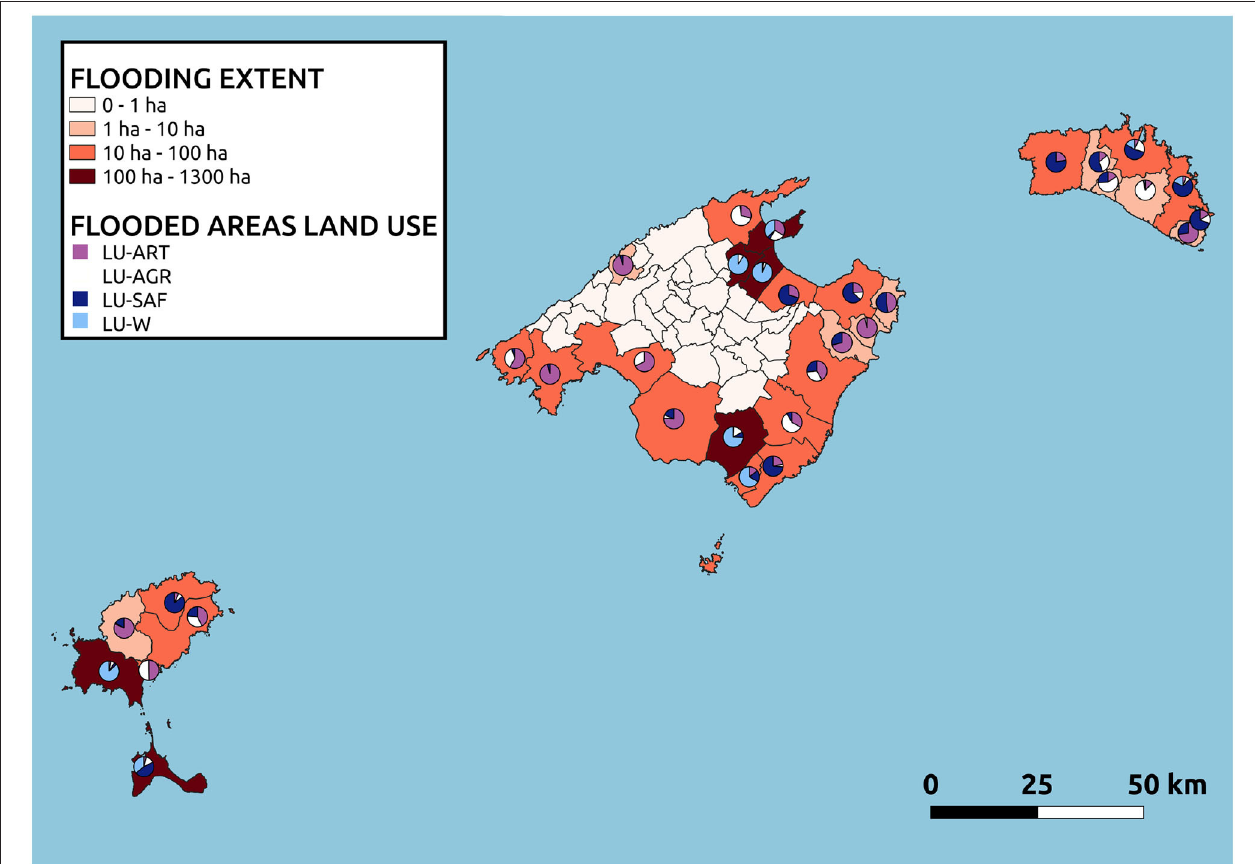
FIGURE 6 | Permanent flooding extent (classified by municipality) for the case of 103 cm of MSLR, with information on land use of flooded areas. Each municipality polygon is colored according to its flooding extent, and has a circular symbol containing the fractions of land use composing that extent (LU-ART, LU-AGR, LU-SAF, LU-W; see Section 3.3.3 for the land use